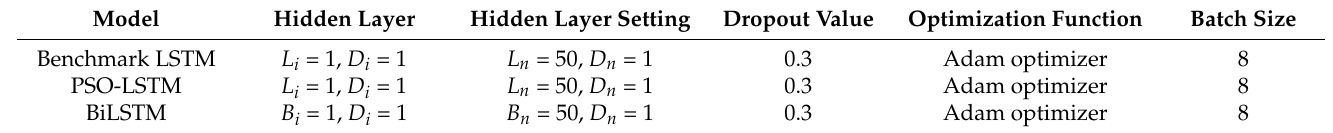
Table 2. Structure of the monthly average runoff prediction